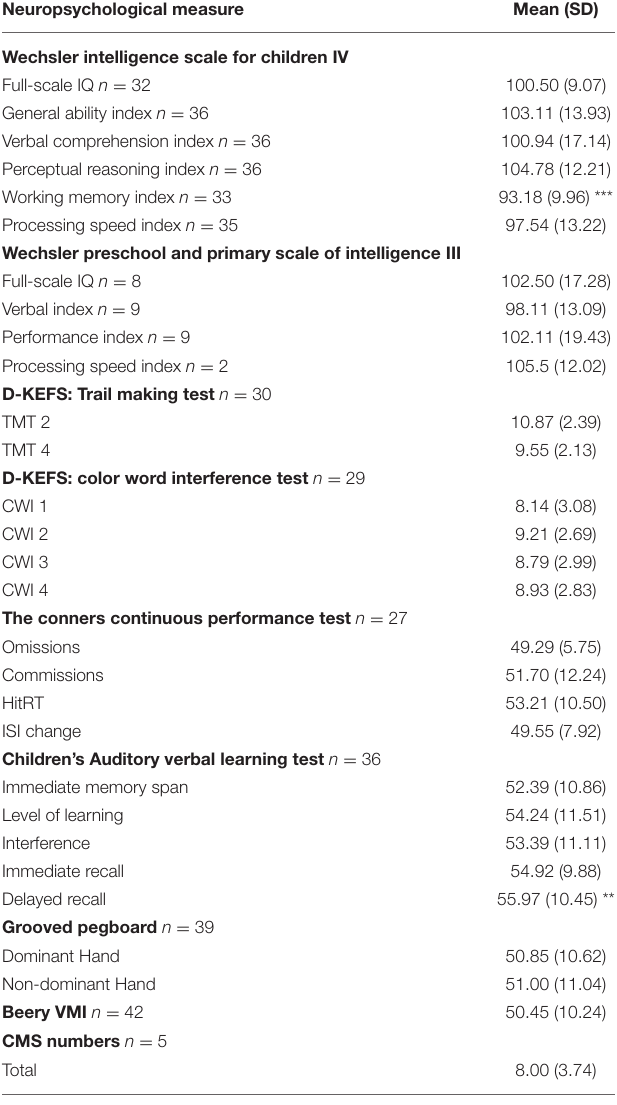
TABLE 3 | Neuropsychological